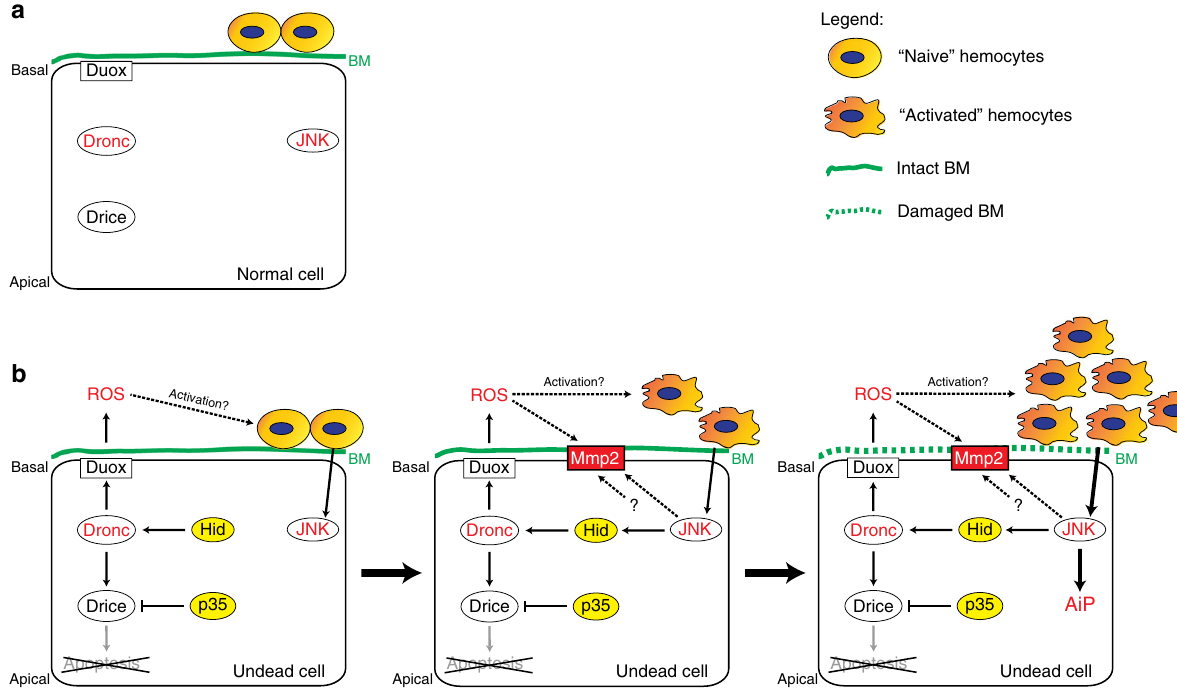
Fig. 7 Summary model. a In normal epithelial cells, Duox, JNK, Dronc, and Drice are synthesized, but are inactive. The basement membrane (BM) is intact and naive hemocytes are attached to the eye-antennal imaginal disc at the basal side of the disc proper. Please note the apical-basal polarity of the cells. b (left) In undead epithelial cells, expression of hid activates Dronc, but apoptosis is blocked due to co-expression of p35 which inhibits Drice and generates the undead condition. Instead, Dronc activates Duox which synthesizes extracellular ROS. These ROS may provide the initial stimulus for activation of the naive hemocytes. b (middle) Activated hemocytes release factors including the TNF ortholog Eiger which signal back to the undead cells. JNK is activated and induces the expression of hid , setting up an ampli fi cation loop. JNK — directly or indirectly — also induces the expression of Mmp2 resulting in accumulation of Mmp2 protein at the basal side of the plasma membrane. ROS may also further activate Mmp2. b (right) Mmp2 damages the BM at the basal side. The BM damage recruits additional hemocytes to further strengthen the ampli fi cation loop, resulting in